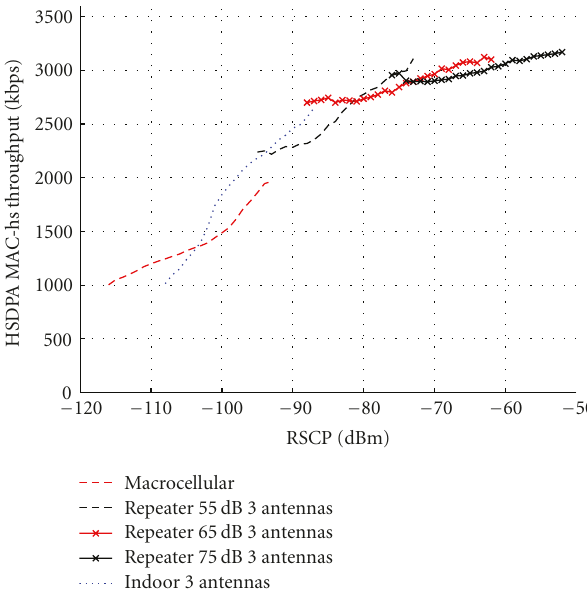
corridor. Macrocellular, repeater and indoor systems, 3 antenna configuration.